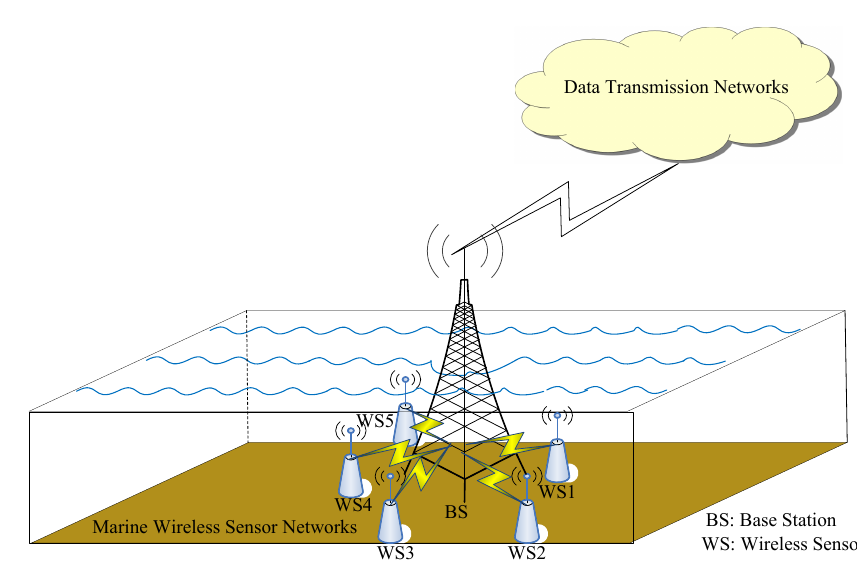
Figure 1. Data collection in marine wireless sensor networks